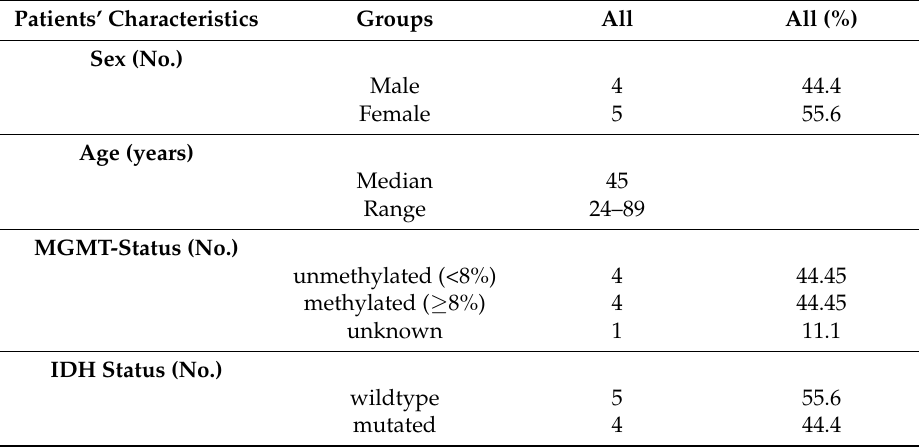
Table 3. Patients’ characteristics. MGMT: O6-methylguanin-DNA methyltransferase, IDH: isocitrate